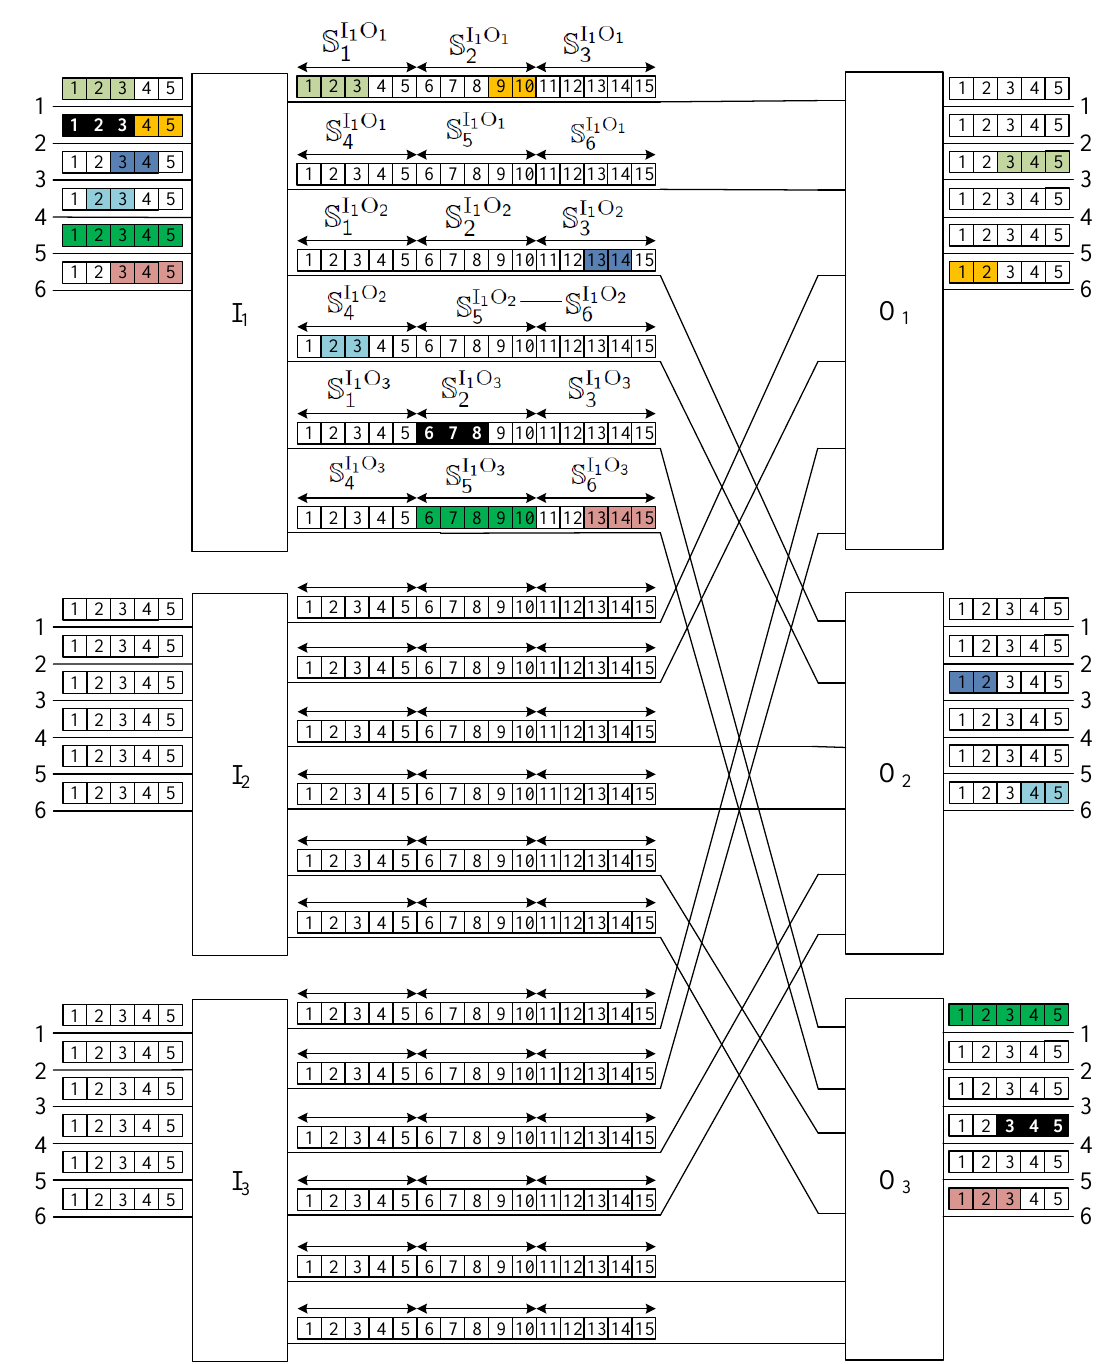
Figure 5. A new request (cid:104) I 1 ;2;1;O 3 ;4;3;3 (cid:105) (marked in black color) in the CC ( 6,3,2,5,15 ) switch- ing